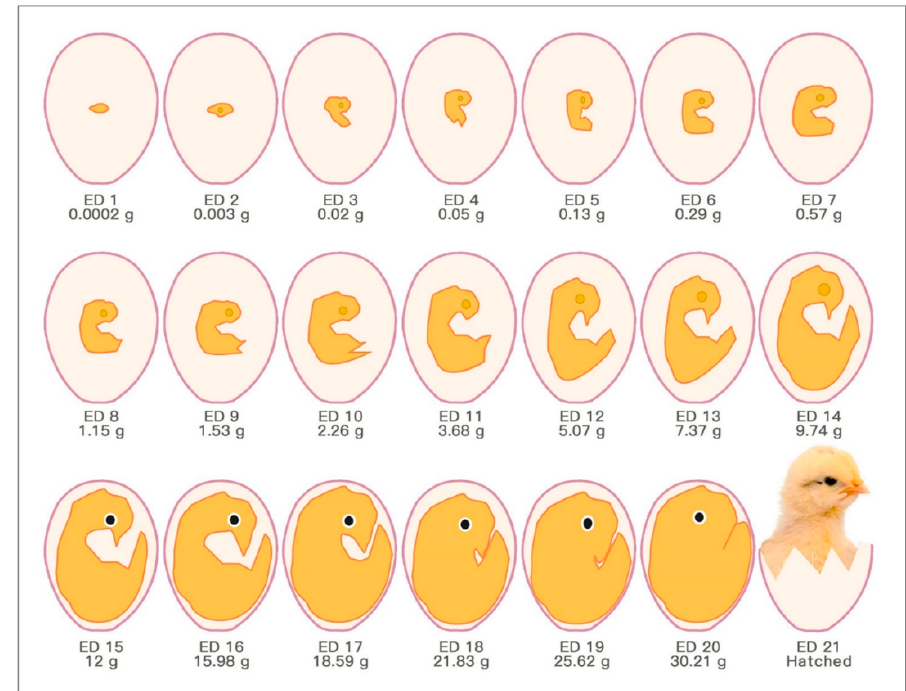
Figure 1. Schematic drawings of chronological chick embryo development.